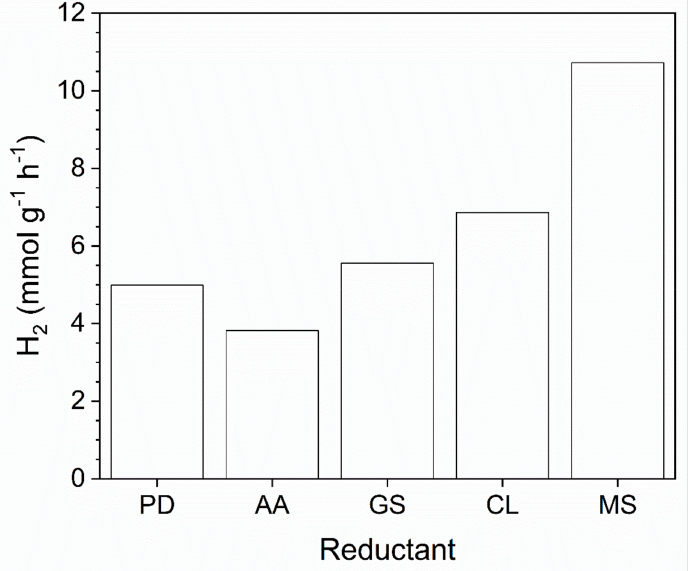
Figure 2. Hydrogen productivity with Pt@PC500 (T = 30 ◦ C, c Pt@PC500 = 0.5 g L − 1 ) prepared by photodeposition (PD), and the colloidal approach with different reductants (AA: ascorbic acid, GS: grape seed, CL: clove, MS: mangosteen) measured with a 300 W Xe lamp (full spectrum) and ethanol (10 vol.%) as the sacrificial